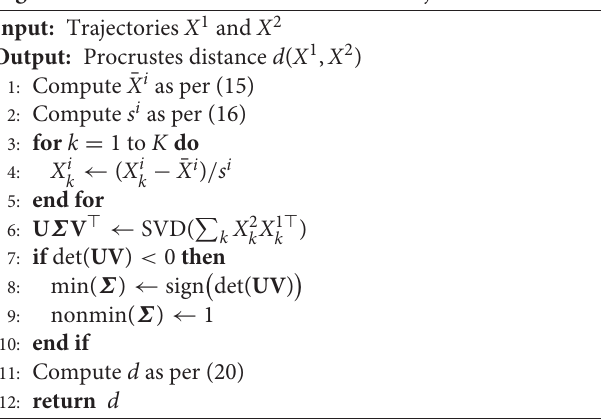
Algorithm 1 : Procrustes distance between